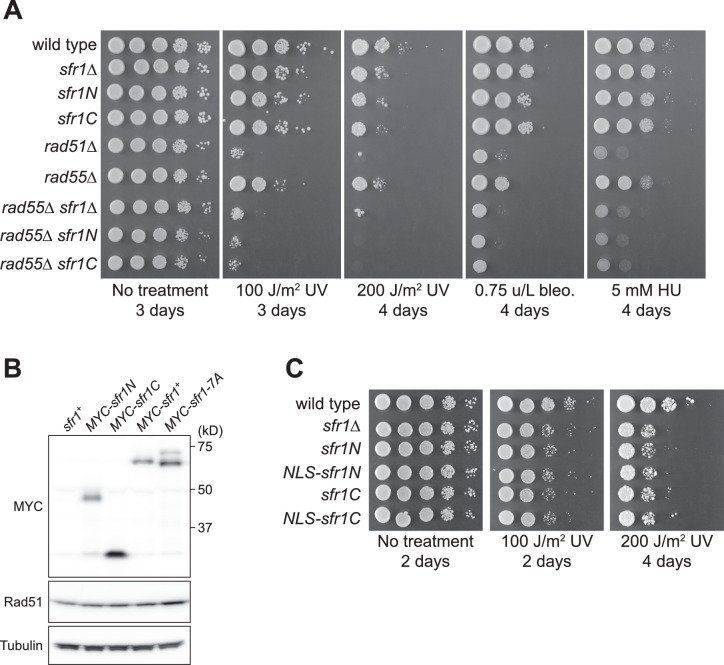
The DNA damage sensitivity of sfr1N/C is not due to protein instability and is not suppressed by fusion to an NLS.(A,C) DNA damage sensitivity of the indicated strains was assessed. NLS, nuclear localization signal of the SV40 large T antigen. Bleo., bleomycin. HU, hydroxyurea. Note that sfr1Δ does not sensitize cells to the indicated doses of bleo. or HU unless Rad55/Rad57 is absent. (B) Proteins were extracted from log phase cultures, separated by SDS-PAGE and probed with the indicated antibodies. Tubulin serves as a loading control.